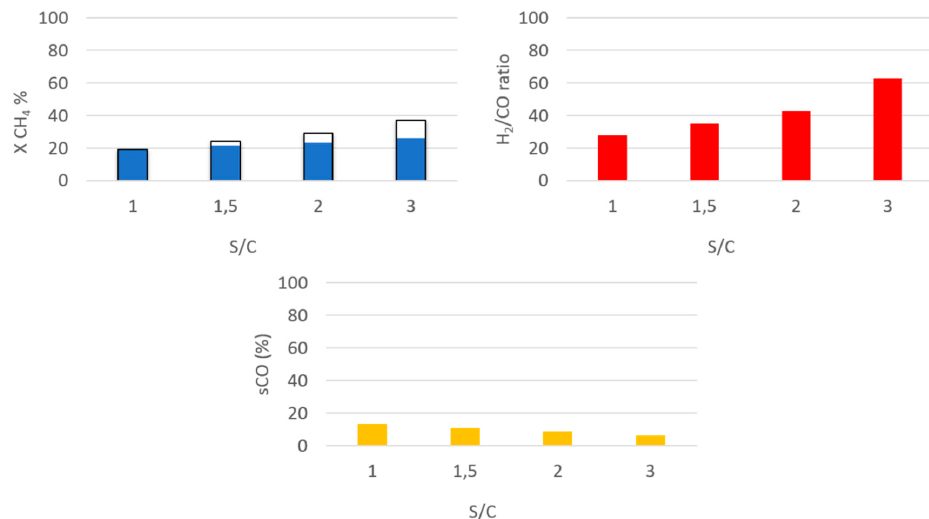
Figure 5. Comparison among tests carried out on Rh0.6-CL-R-CZOm at 30,000 h − 1 , 1 atm and 500 ◦ C. The graphs report the methane conversion (blue) with respect to the equilibrium values (white bars with black frames), H 2 / CO ratio (red), and CO selectivity (yellow) versus di ff erent S / C ratios.